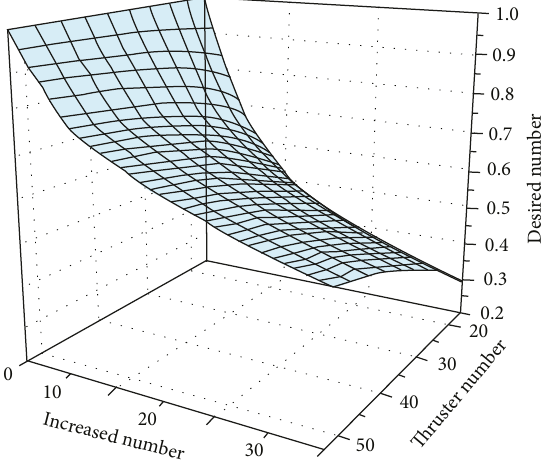
Figure 15: Energy